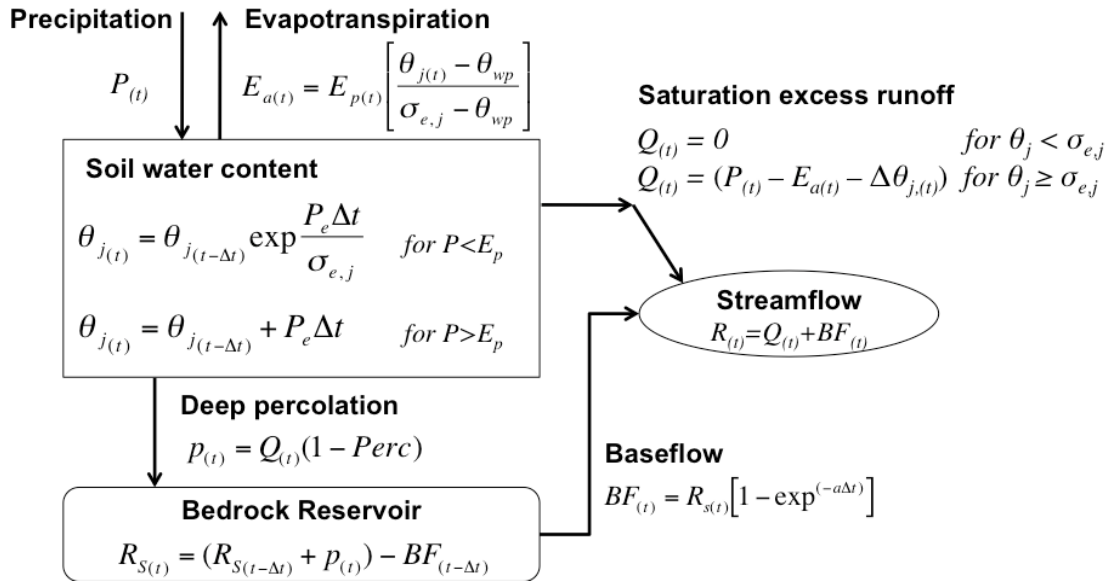
Figure 2. Conceptual diagram of the water balance model, which estimates the soil water in each wetness class j and the saturation excess runoff, Q , at the watershed content θ j in each time step (t). E is outlet using precipitation, P , and potential evapotranspiration E p a and θ are the soil water content at field capacity and at the actual evapotranspiration, θ fc wp is the maximum effective soil storage of wetness class j , P wilting point respectively, σ e , j e = P − E ), Perc is a percolation coefficient determining the is the effective precipitation ( P e p and a is a recession coefficient amount of water, p , percolating to the bedrock reservoir, R s controlling the rate at which baseflow, BF , is contributed from the bedrock reservoir to the watershed’s streamflow, R